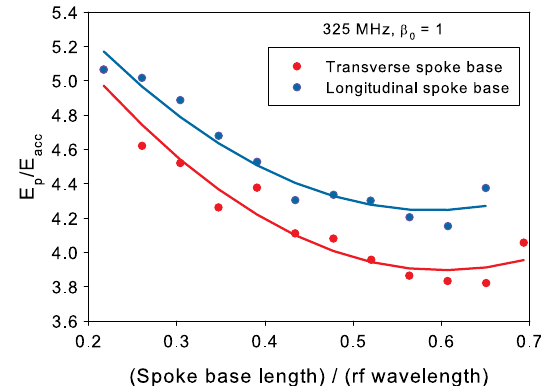
FIG. 7. Dependence of normalized electric field on spoke base length for longitudinal and transverse orientations. The leftmost point is common to both curves since it represents a cylindrical spoke base.